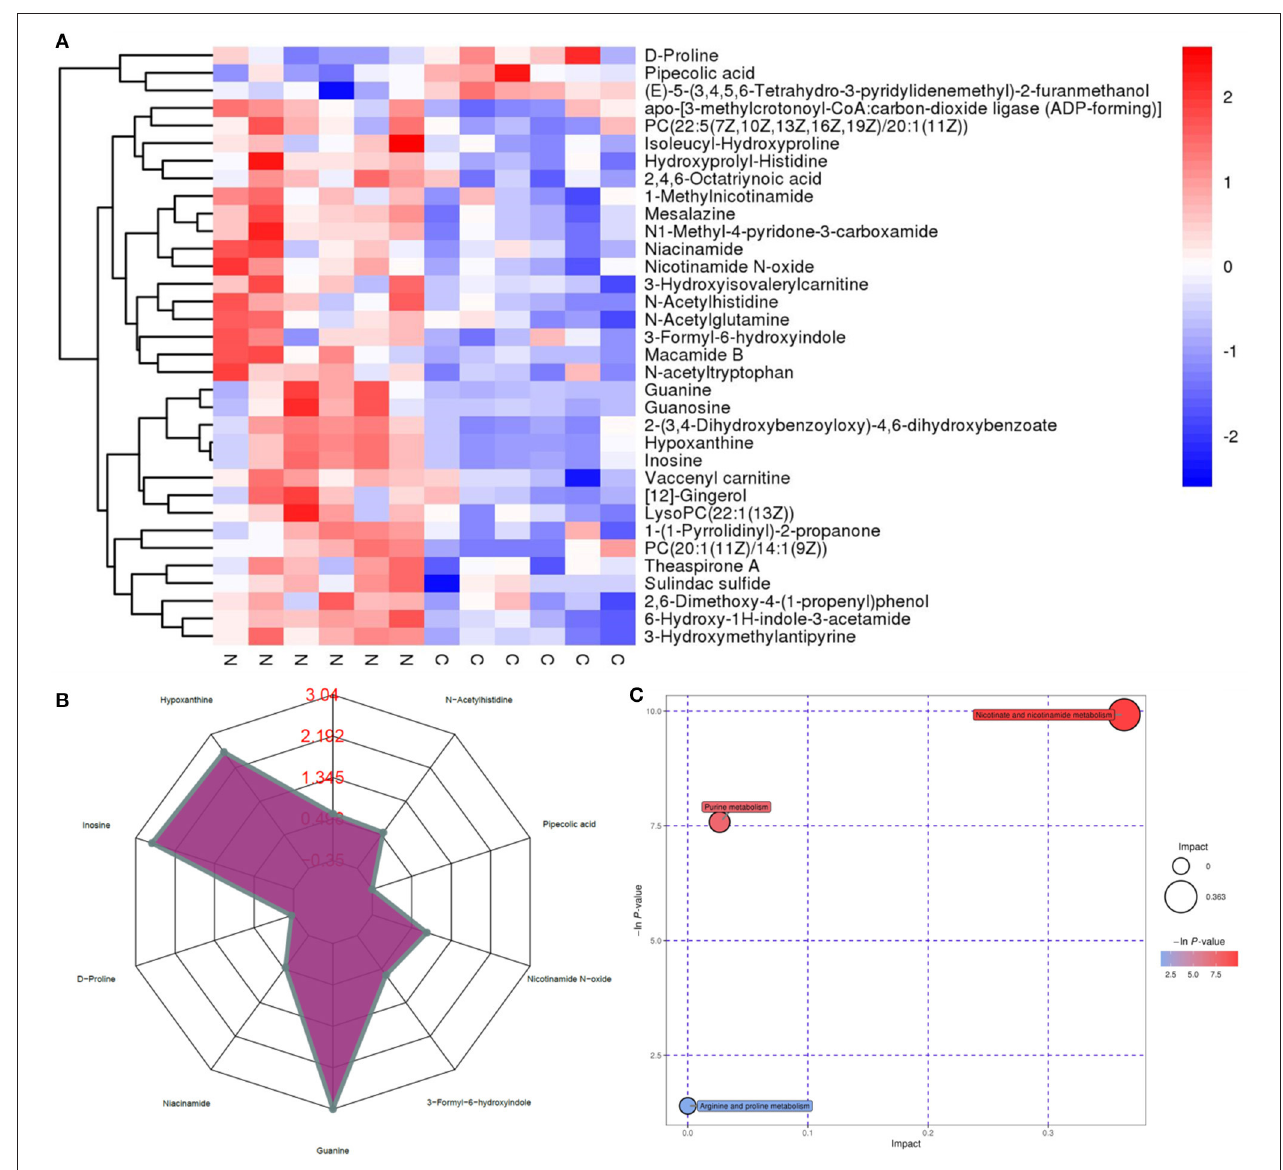
FIGURE 3 | Supplementary effect of NMN on the top 34 metabolic biomarkers and main metabolic pathways in pre-aging mice by hierarchical clustering analysis. (A) heatmap of hierarchical clustering analysis, (B) radar chart, and (C) pathway analysis (NMN group vs. control group).